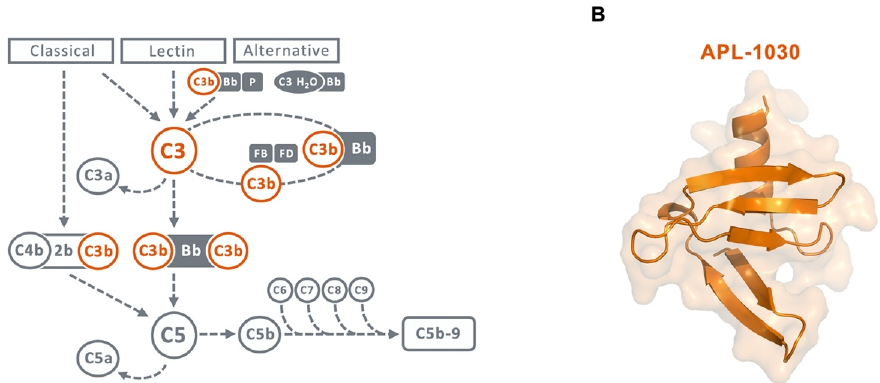
Figure 1. ( A ) Scheme of the complement cascade highlighting the central role of C3 and C3b in the amplification loop. Therapeutic targets for inhibition by APL-1030 are marked in orange. ( B ) Ribbon and surface representation of the 3D structure of APL-1030, with C-terminal alpha helix (top) and N-terminal end (bottom).